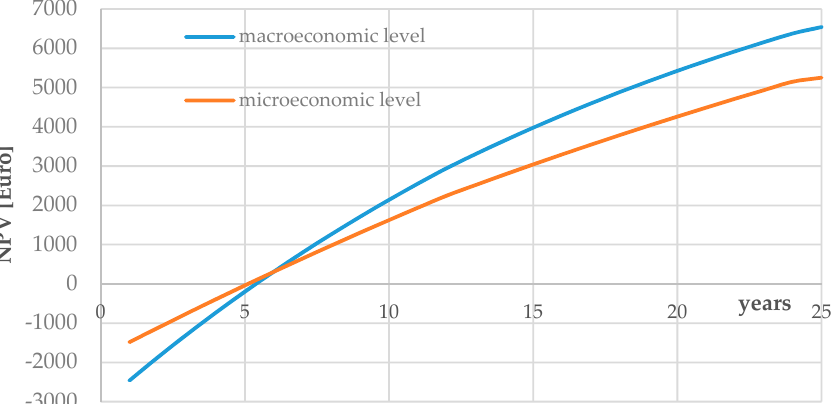
Figure 7. The Discounted Payback Period on a micro- and macroeconomic level for the calculation variant: location—Podkarpackie Voivodship; building orientation–southern; roof inclination angle—30°.